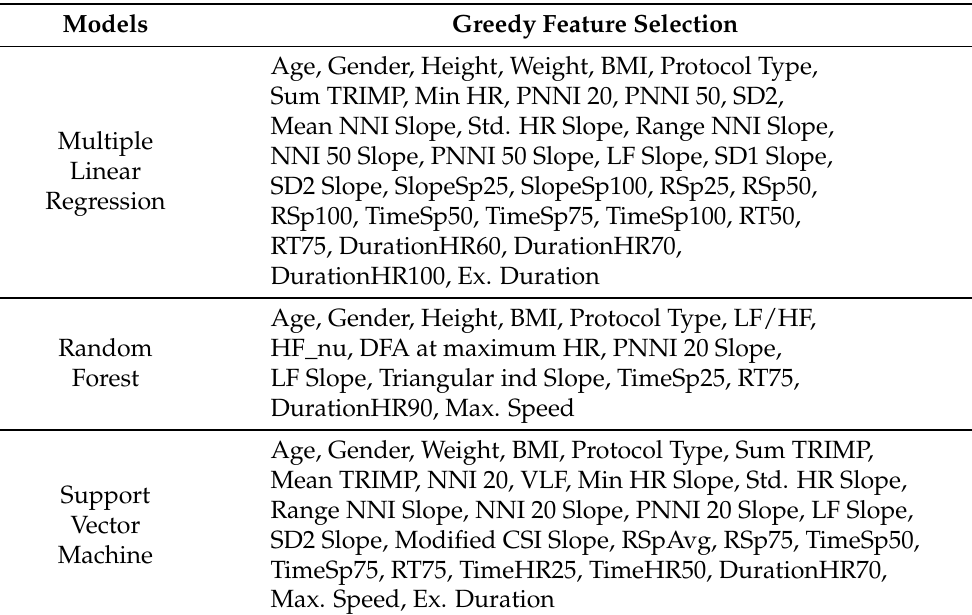
Table A3. Best Features selected based on Greedy-based Feature selection on exercise